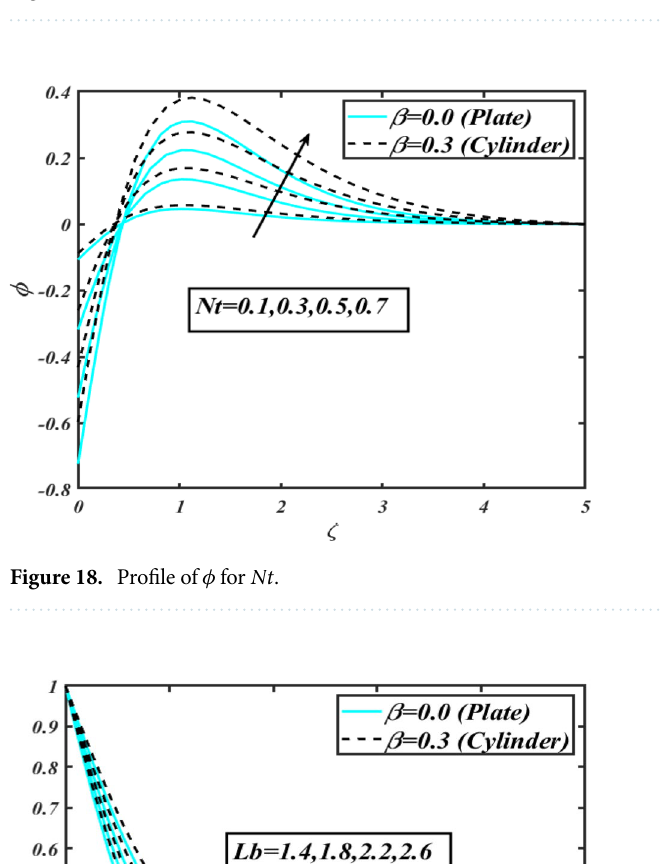
Figure 17. Profile of φ for Nb .